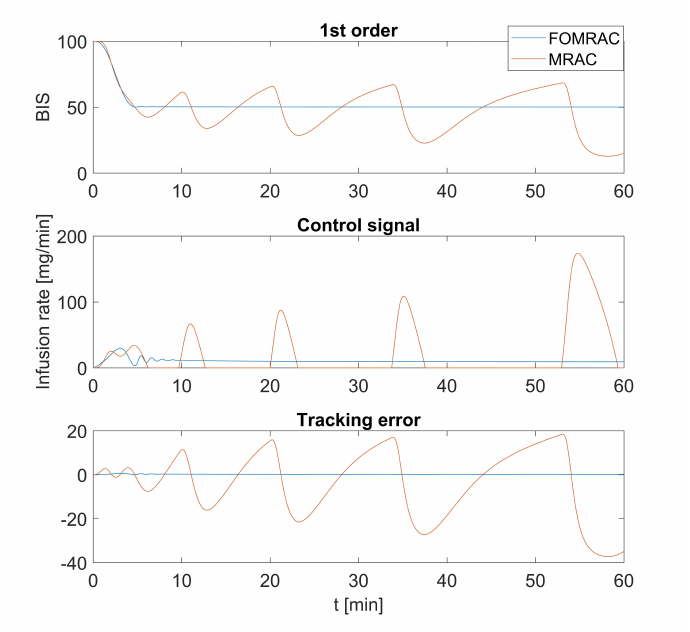
Figure 25. Comparison between the 1st-order FOMRAC and the model reference adaptive control (MRAC), BIS output, control signal, and tracking error.